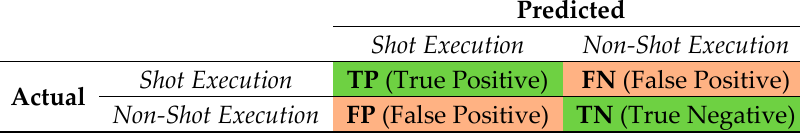
Figure 1. Confusion matrix for risk classification.